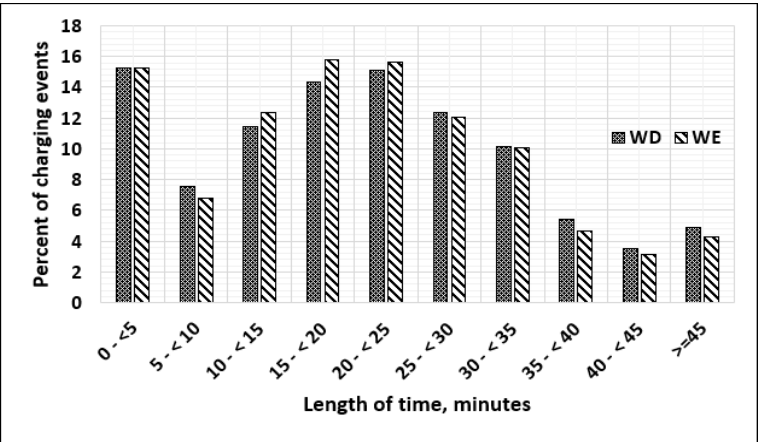
Figure 9. Distribution of length of time with a vehicle drawing power from an FCS per charging event [30].